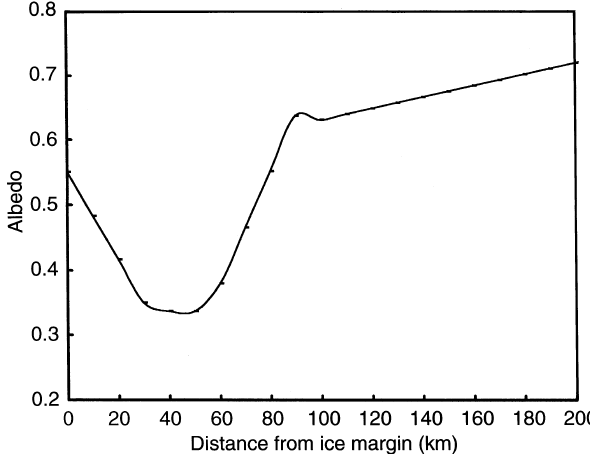
Fig. 3. Surface albedo obtained from GIMEX data (van de Wal and Oerlemans,